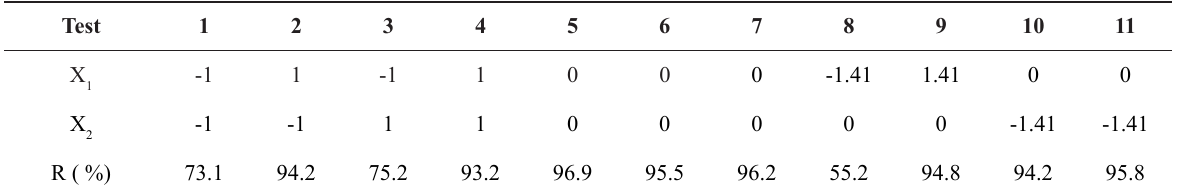
Design matrix and color removal rates, R 1